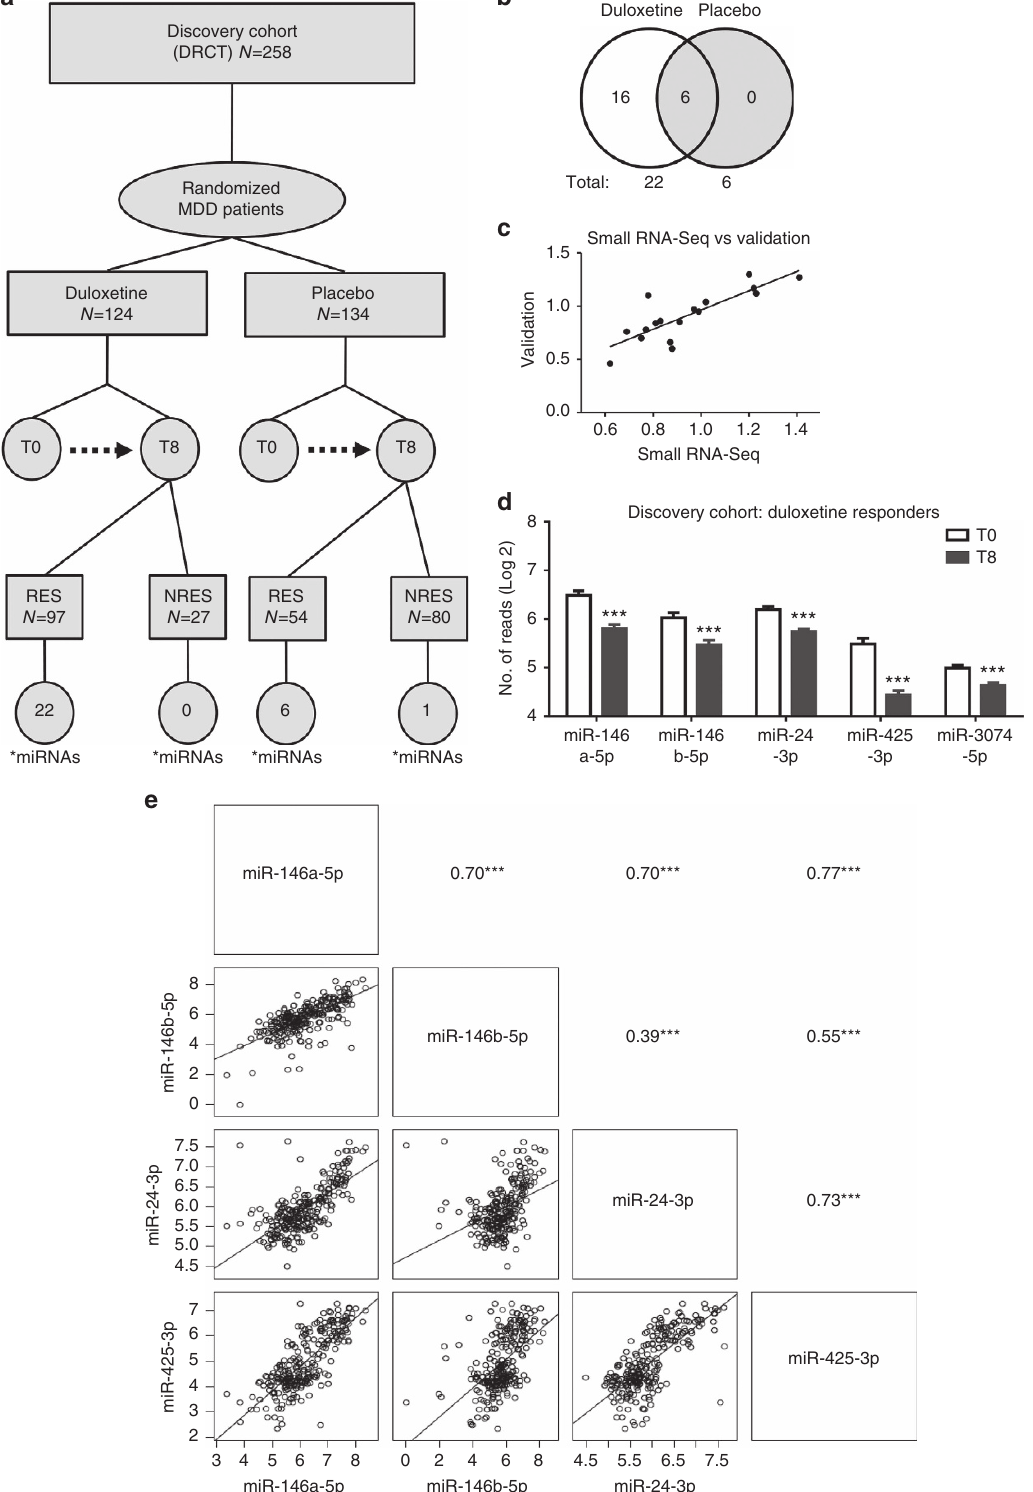
Figure 1 | MicroRNA changes after 8 weeks of AD treatment. ( a ) Experimental design. Discovery cohort (DRCT), baseline (T0), 8 weeks of treatment (T8), responders (RES) and nonresponders (NRES), *Number of significant miRNAs. ( b ) Venn diagram showing specific and commonly dysregulated miRNAs in duloxetine and placebo responders. ( c ) Correlation between miRNAs measured by small RNA-sequencing and a high-sensitivity multiplex cellular miRNA assay on a standard flow cytometer (Firefly BioWorks). ( d ) Small RNA Sequencing expression (number of reads per million, Log2) of miR- 146a-5p, miR-146b-5p, miR-24-3p, miR-425-3p and miR-3074-5p after 8 weeks in MDD patients who responded to duloxetine treatment. ***FDR corrected P o 0.001. ( e ) Scatterplots of Pearson’s correlations between differentially expressed miRNAs in blood samples from the discovery cohort. *** P o 0.001. NATURE COMMUNICATIONS|8:15497|DOI: